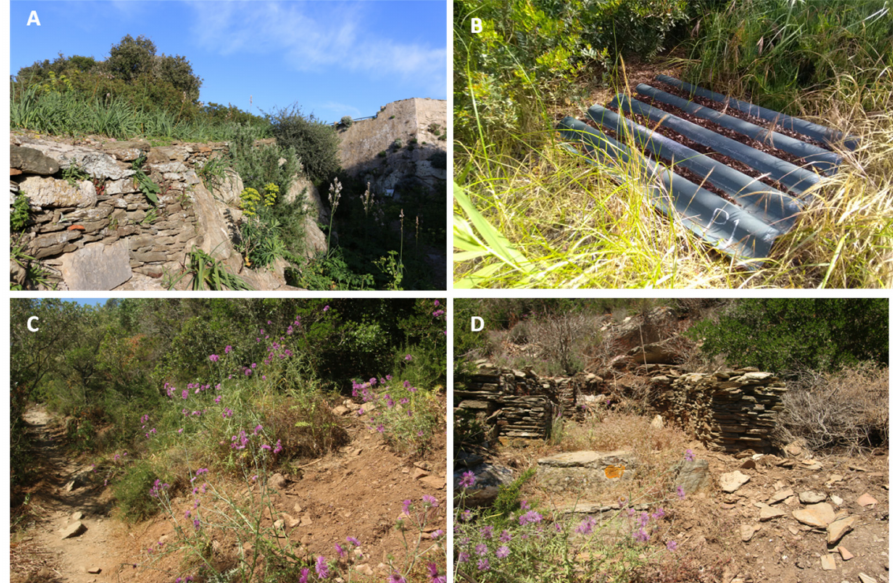
Figure 2. Sampling locations on Port-Cros before ( A , B ) and after wild boar outbreak in 2016 ( C , D ). Image ( A ) shows an intact dry stone wall. Image ( B) shows corrugated fibrocement coverboard positioned along a hedge in a meadow. Image ( C ) shows rooting of the ground, leading to the disappearance of the herbaceous layer and of many shrubs. Image ( D ) shows the partial destruction of a stone wall. Overall a variety of habitat types was affected, we estimated that 60% to 80% of the whole area was